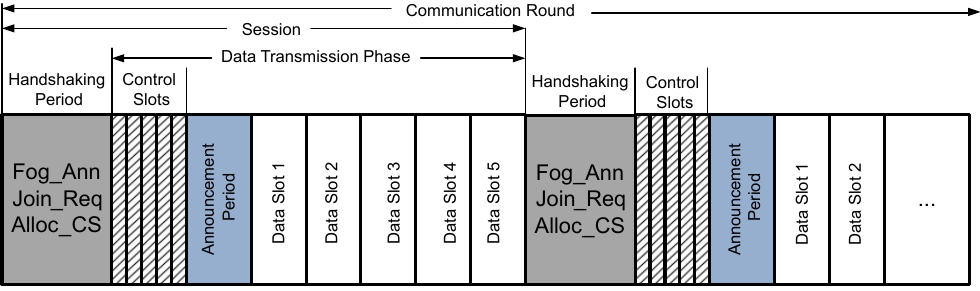
Figure 3. A communication round of the proposed MAC for mining nodes in vehicular